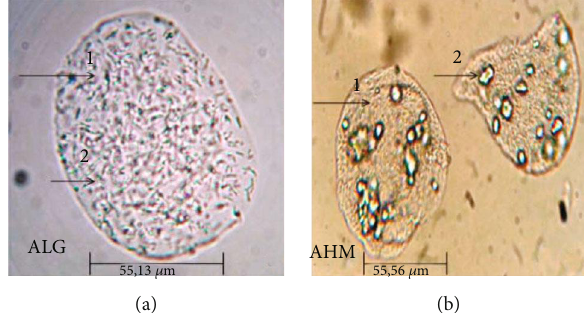
Figure 6: Optical micrographs of both alginate and alginate + Hi − maize (AHM) microparticles (a) alginate microparticle. Label 1 indicates sodium alginate inside the particle, and label 2 indicates the microorganism within the particle (100 × magni fi cation); (b) AHM microparticles, in which label 1 shows the sodium alginate in the interior of the particle, and label 2 shows the prebiotic Hi-maize (60 × ). Pictures are representative of triplicates [23].